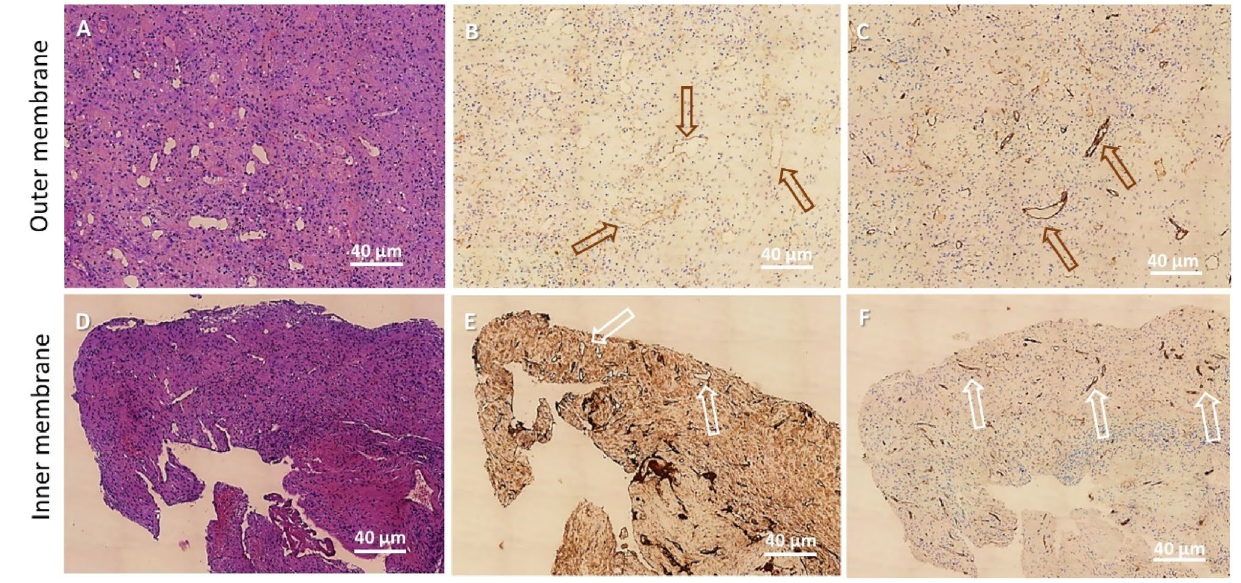
Figure 6. Hematoxylin and eosin histochemical staining of outer membrane ( A ) and inner membrane ( D ). Immunohistochemical modifications of the outer membrane ( B – C ) and the inner membrane ( E – F ) surrounding a CSDH. An increase in fibrotic tissue and neovascularisation are the main aspects detected. The neoformed CD31+ vessels (arrows), ( B : outer membrane; E : inner membrane), appear to increase in number in the inner membrane and seem to be arranged in a different distribution pattern compared to CD34 + vessels ( C : outer membrane; F : inner membrane). Haematoxylin and Eosin 100 × ( A , D ); CD31 stain 100 × ( B , E ); CD34 stain 100 × ( C , F ). Bar = 40